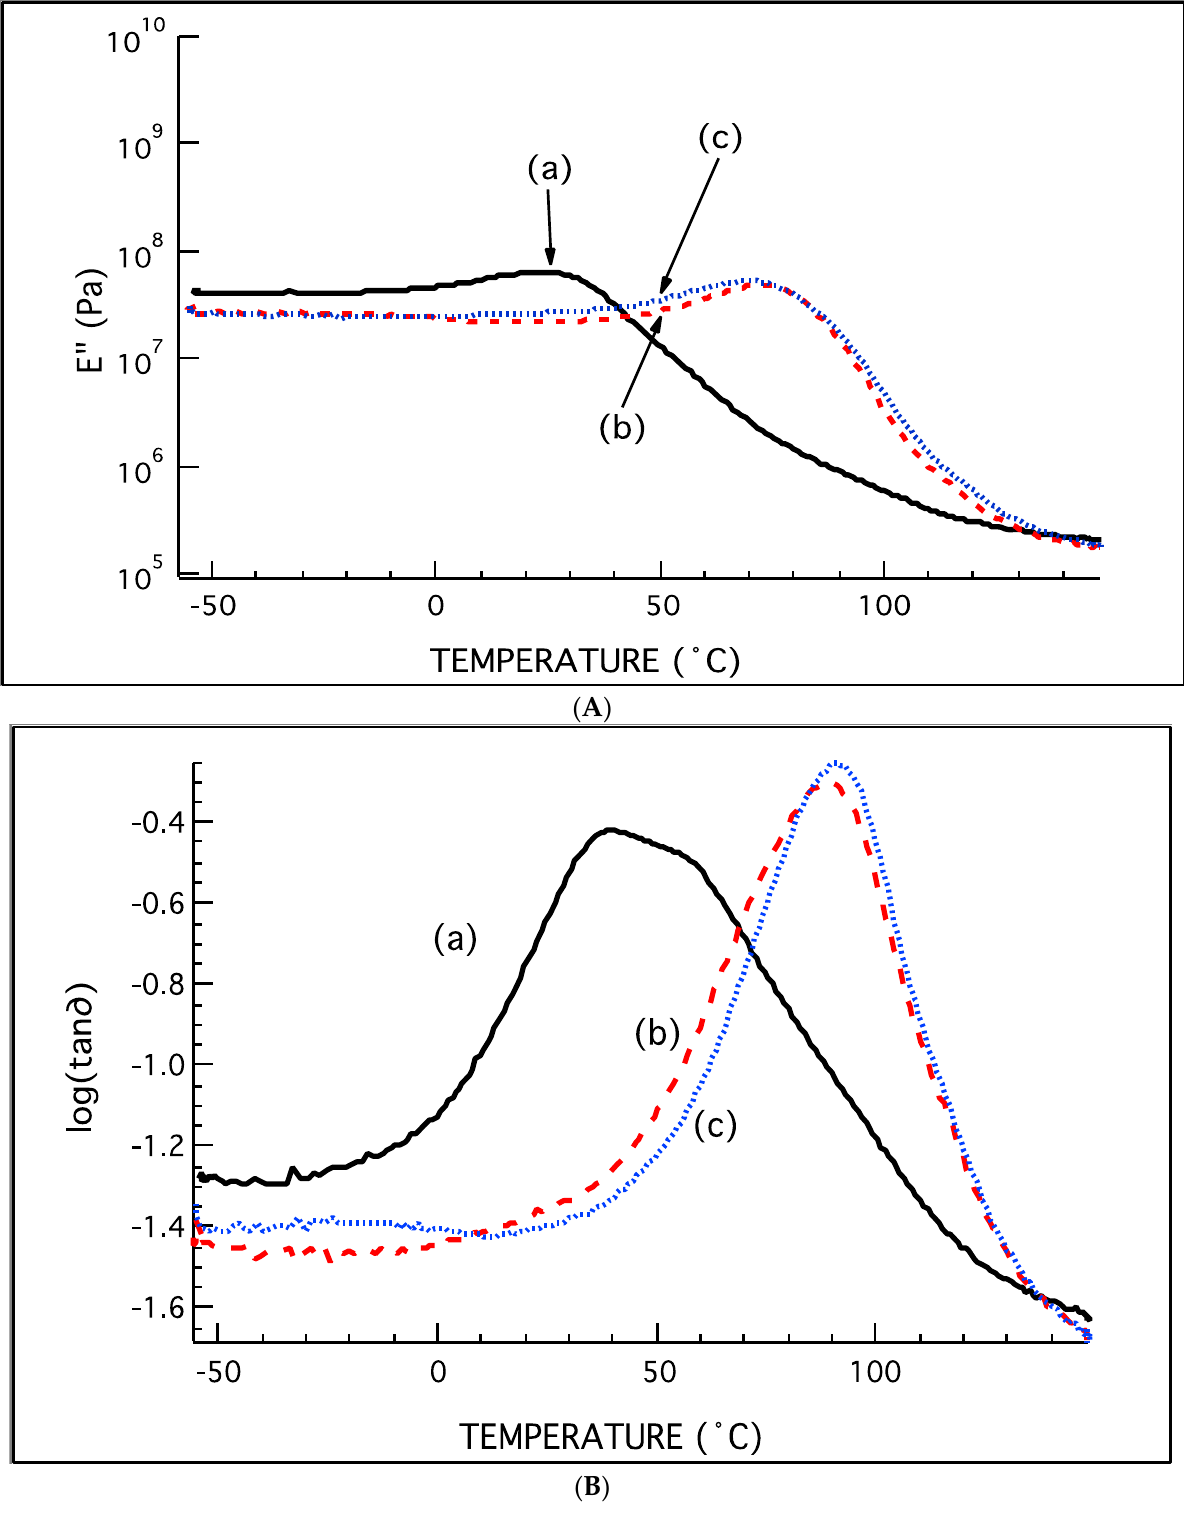
Figure 8. ( A ) Comparison of the loss modulus for epoxy filled with microcapsules synthesized using a water:oil ratio of 5.5:1 and run for three cycles: (a) first cycle; (b) second cycle; (c) third cycle. ( B ) Comparison of log (tan( ∂ )) for epoxy filled with microcapsules synthesized using a water:oil ratio of 5.5:1 and run for three cycles: (a) first cycle; (b) second cycle; (c) third